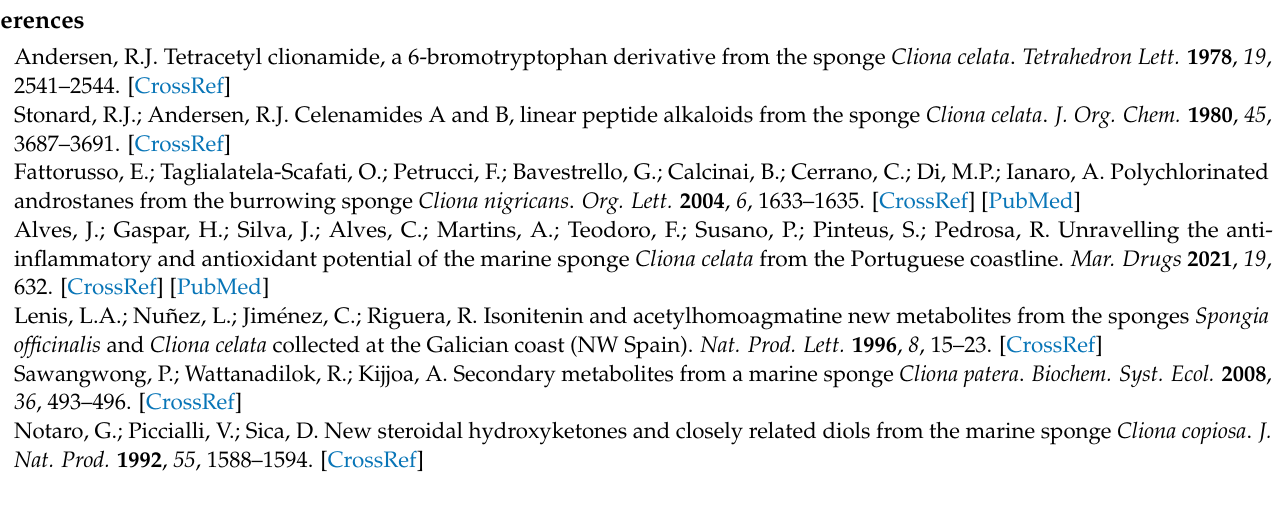
1 . Figure S2: UV spectrum of 1 . Figure S3: IR spectrum of 1 . Figure S4: 1 H NMR spectrum of 1 . Figure S5: 13 C NMR spectrum of 1 . Figure S6: HSQC spectrum of 1 . Figure S7: 1 H- 1 H COSY spectrum of 1 . Figure S8: HMBC spectrum of 1 . Figure S9: NOESY spectrum of 1 . Figure S10: Regression calculations on the plots of δ calcd. against δ exptl. for plausible structures of 1 . Table S1: Absolute errors between computed 13 C chemical shifts and experimental data of 1 . Table S2: DP4+ results for conformers ( 1A -isomer and 1B -isomer). Figure S11: Stable conformers of (1 R *, 6 S *, 7 S *, 10 S *)- 1A used in ECD calculation. Table S3: Boltzmann distribution percentages of stable conformers of (1 R *, 6 S *, 7 S *, 10 S *)- 1A . Biological assay. Refs. [24–26] are cited in Supplementary Materials